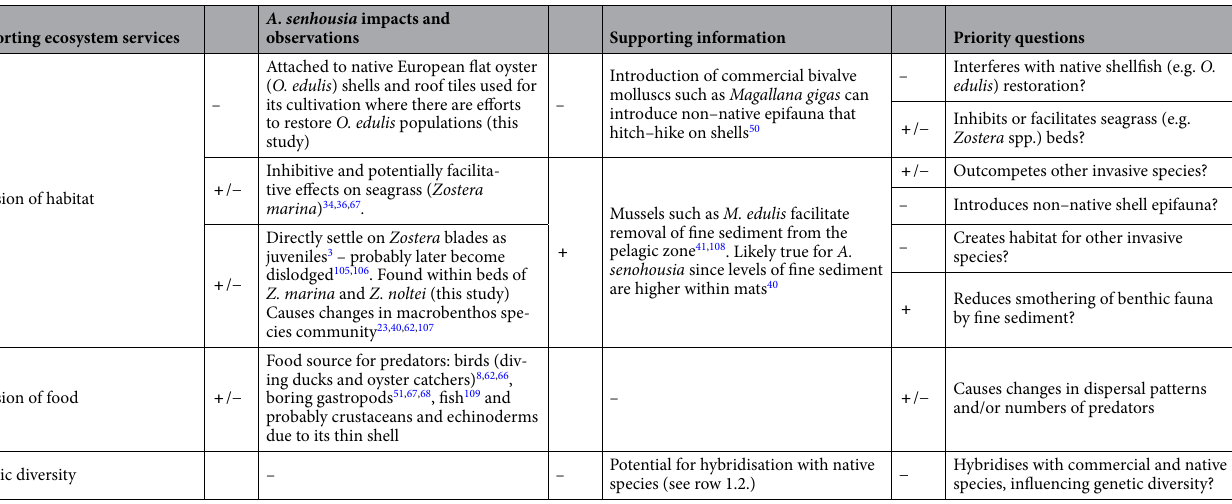
Table 4. A summary of the impacts of A. senhousia in relation to Supporting ecosystem services. ( +) denotes a potentially positive impact, (–) denotes a potentially negative impact. Priority questions are those that should be addressed by researchers to generate a full risk assessment and management plan.